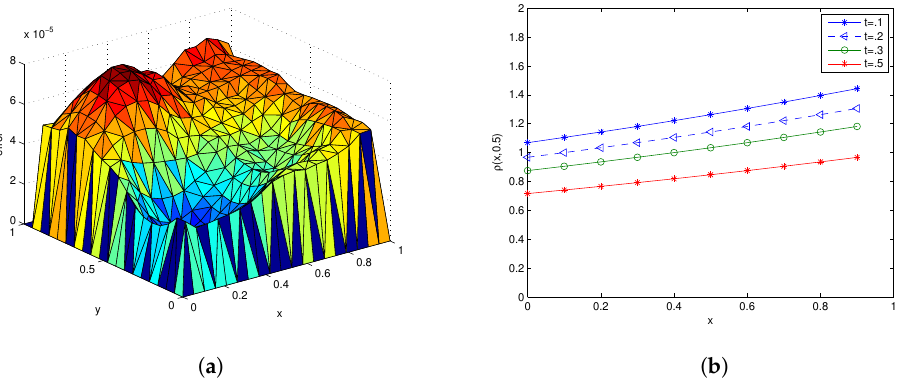
Figure 7. ( a ) Point wise error, when t = 1, ns = 20 and δ t = 0.0001, and ( b ) numerical solution, corresponding to Example 3. Table 3. Numerical results corresponding to Example 3 in [ 0,1 ] 2 .